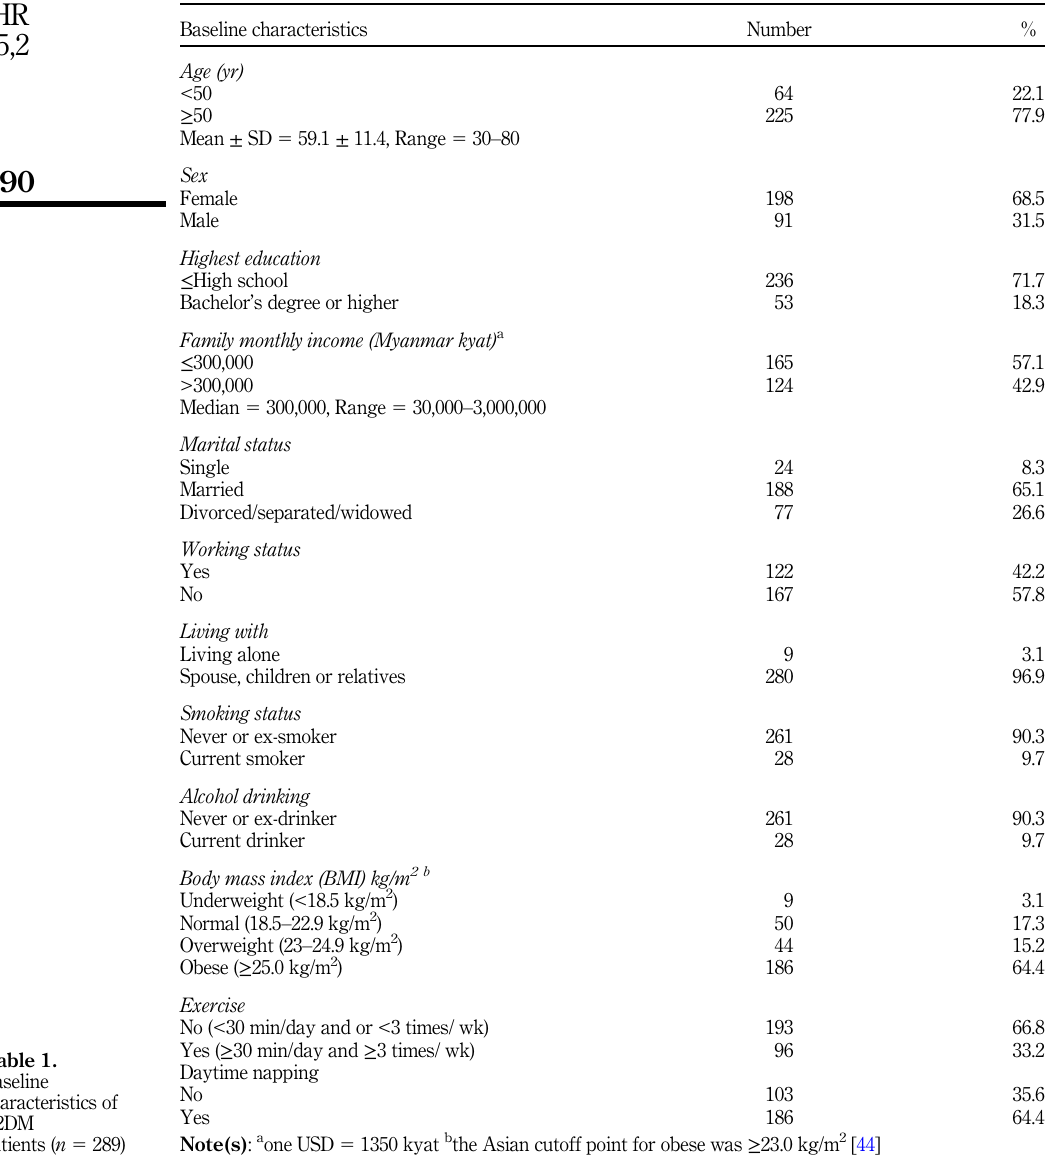
characteristics of T2DM patients ( n 5 Depression and family relationships Concerning depression status, 72.3% of 289 T2DM patients had “ normal ” scores while 19.4% had mild depressive symptoms, 5.2% had moderate depression and 3.1% had moderate – severe depression. Regarding family relationships, 91.7% had good family relationships